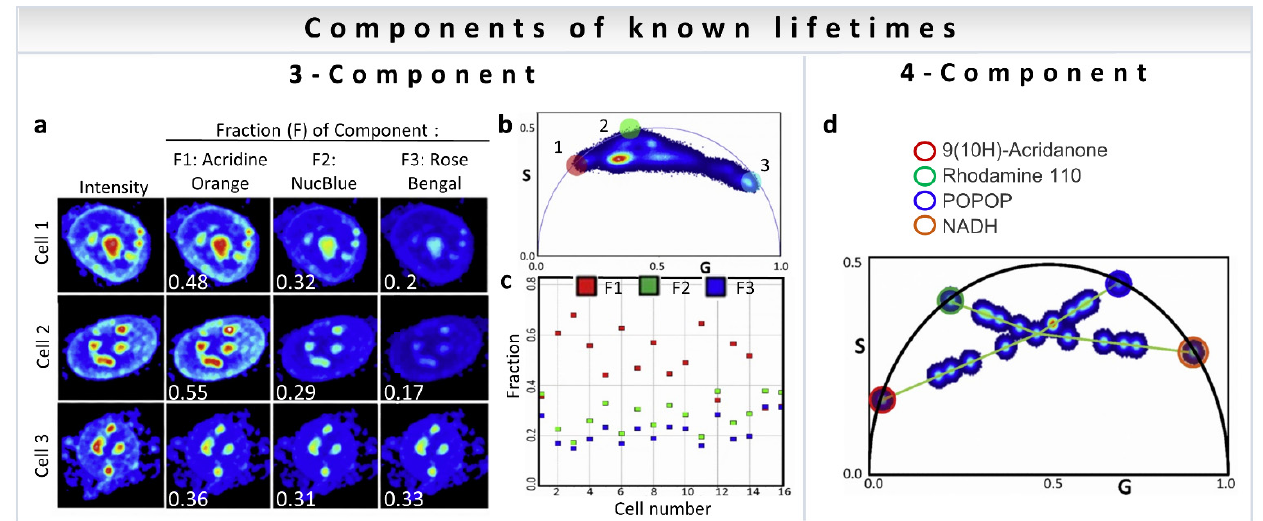
Figure 10. Multiple-component fraction analysis (known lifetimes of the components) to calculate average from an image. ( a – c ) Three-Component fraction analysis (known lifetimes of the components). Obtaining intensity fractions of three nuclear dyes mixed in live cells with three-component analysis. ( a ) Representative images of three different cells, all of them stained with the three nuclear dyes: Acridine Orange (Fraction 1, F1), NucBlue (F2) and Rose Bengal (F3). Total intensity (column 1) and normalized recovered images of the intensity fractions (average fraction written in white) of the three dyes are shown in columns 2–4. ( b ) Phasor plot corresponding to 47 different cells. The colored circles indicate in the phasor plot the phasor position for the first harmonic at 80MHz of Acridine Orange (red circle), NucBlue (green circle) and Rose Bengal (blue circle). ( c ) Fractional intensity values obtained with the three-component analysis of 16 cells. ( d ) Four-Component analysis (known lifetimes of the components) using harmonics. (Panel adapted with permission from [35]). Phasor plot corresponding to 22 different mixtures of 9(10H)-Acridanone (red circle, 12 ns), Rhodamine 110 (green circle, 3.8 ns), POPOP (blue circle, 1.4 ns), and NADH (orange circle, 0.4 ns) (phasor positions of the pure single exponential species on the universal semicircle are shown by circles). To solve the four-component system, the phasor plot was measured at 80MHz (first harmonic) and 160 MHz (second harmonic, not shown). (Panels adapted with permission from [35]).